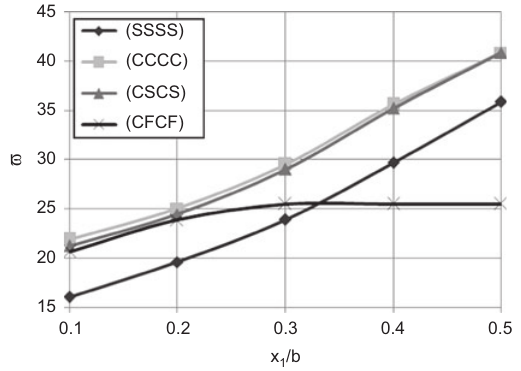
Figure 6 Effect of the position of one intermediate line support on the frequency parameters for square laminated plates for different boundary conditions.